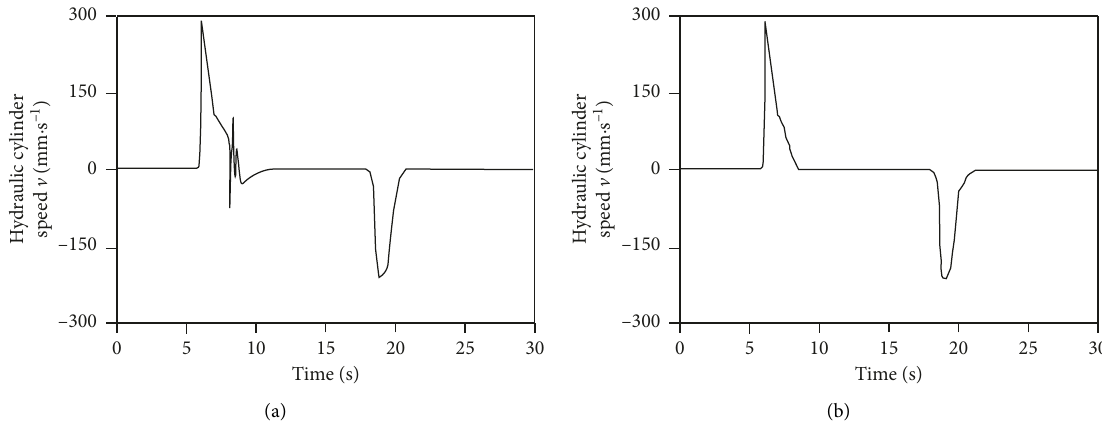
Figure 7: Hydraulic cylinder velocity and displacement curves. (a) Direct switching control. (b) Fuzzy switching control.